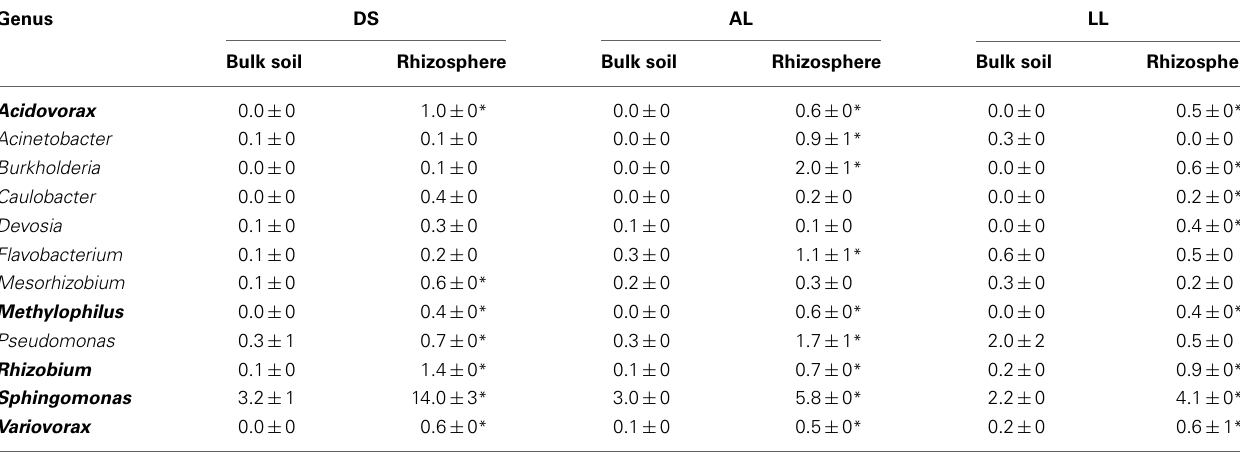
Table 4 | Enriched genera in the rhizosphere of lettuce 7 weeks after planting.